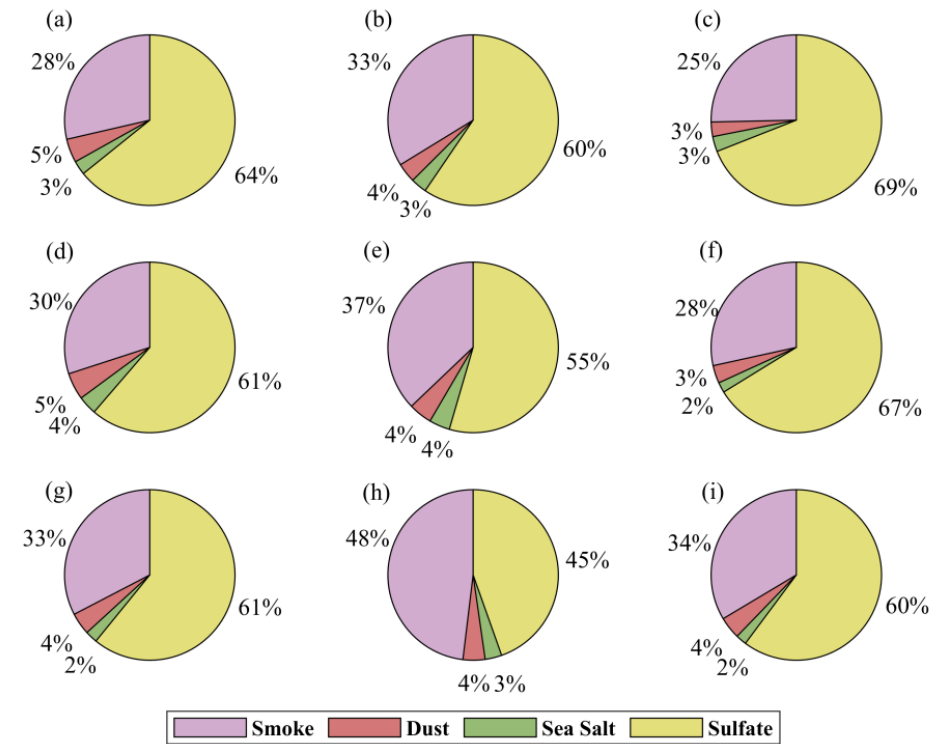
Figure 8. The AOD proportion of sulfate (yellow), sea salt (green), smoke (purple), and dust (pink) under different stages and levels: ( a – c ) slight humidity, ( d – f ) moderate humidity, and ( g – i ) heavy humidity; ( a , d , g ) before-stage, ( b , e , h ) wet-stage, and ( c , f , i ) after-stage.